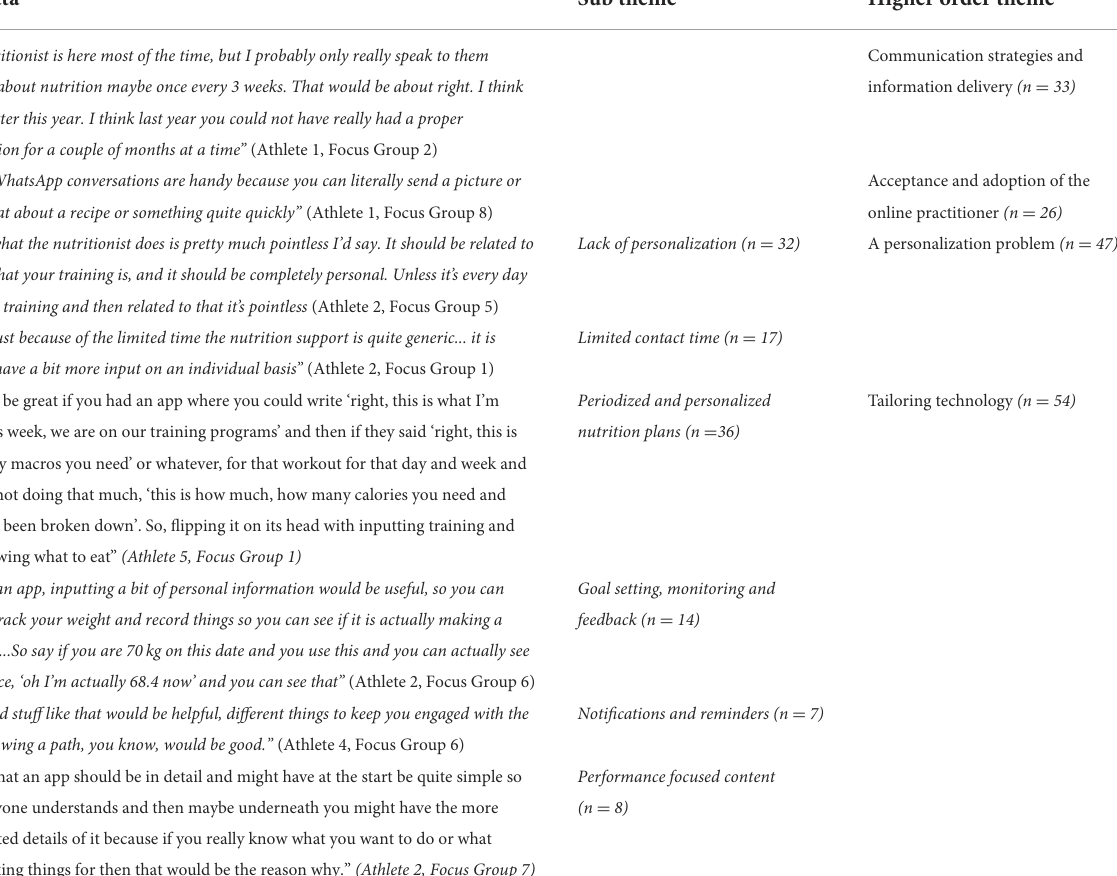
TABLE 1 A summary table of identified